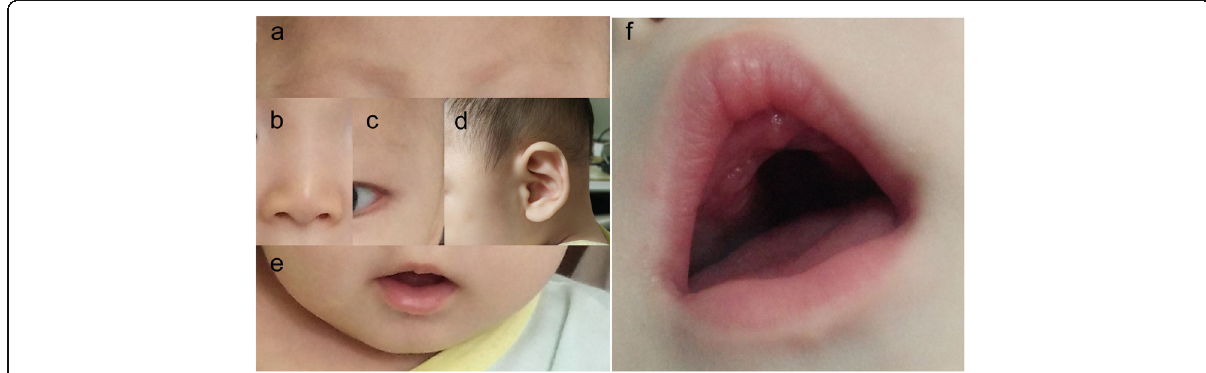
Fig. 2 Typical patient abnormalitie. a Sparse eyebrows, b a depressed nasal tip, c long palpebral fissures with eversion of the lateral part of the lower eyelid, d large prominent ears with low set ears, e micrognathia, f gingival thickening and a high palate with